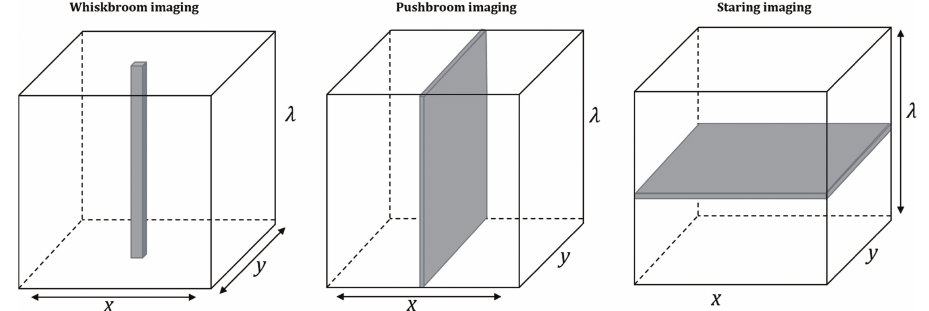
Fig. 3. Hypercubes constructed with three di®erent